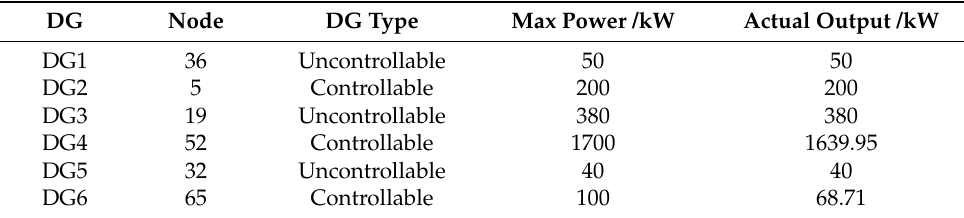
Table 5. The power output of distributed generators.